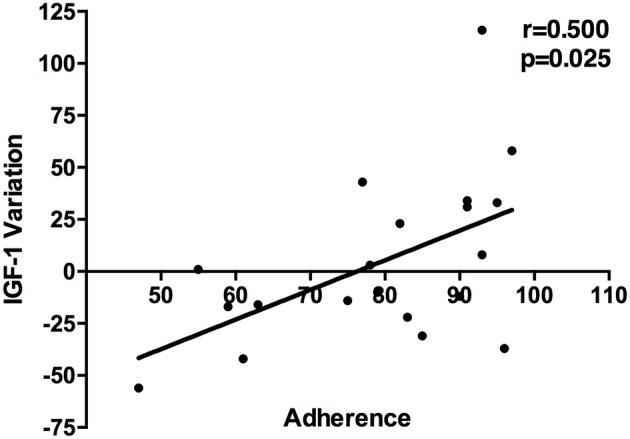
Relationship between adherence and IGF-1 variation throughout the follow up.